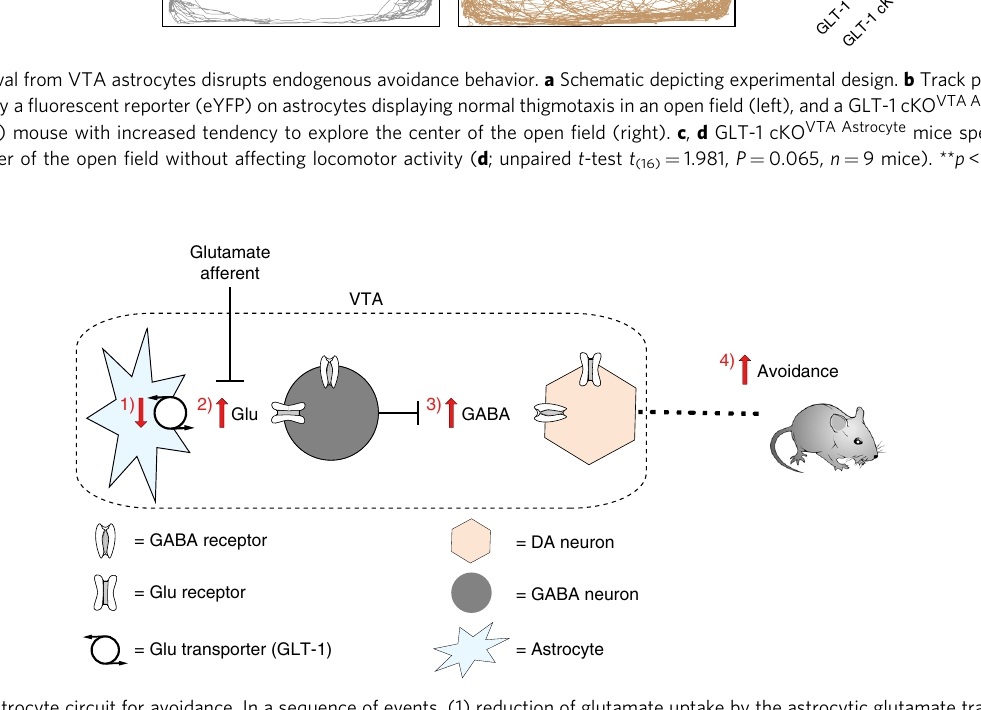
Fig. 9 A neuron-astrocyte circuit for avoidance. In a sequence of events, (1) reduction of glutamate uptake by the astrocytic glutamate transporter, GLT-1, leads to (2) increased glutamate concentration at synapses on VTA GABA neurons. (3) The resultant increase in GABA release at synapses on DA neurons inhibits DA neuron activity, eliciting (4) real-time and learned avoidance